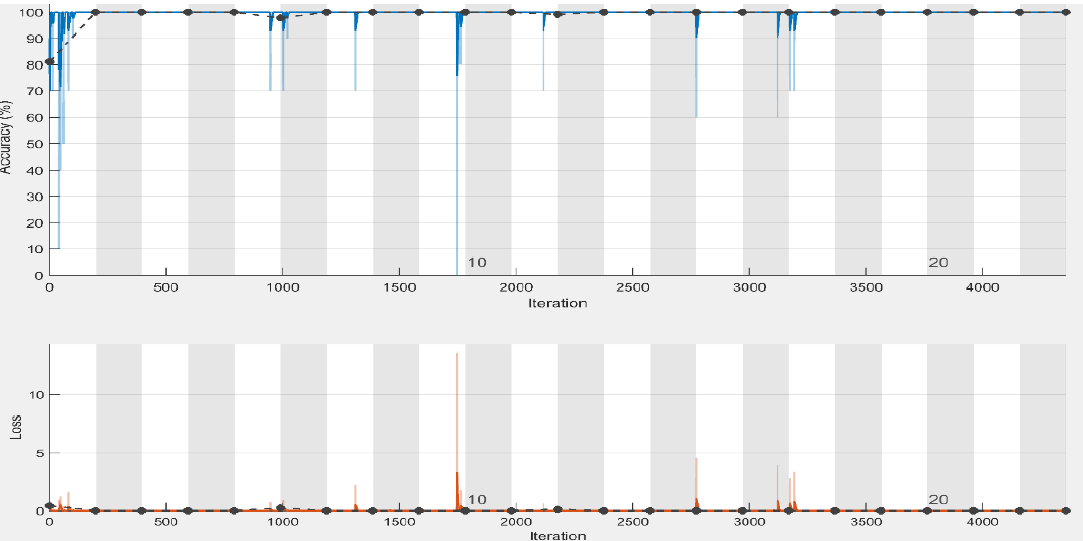
Figure 7. Training and validation accuracy and loss plots of binary classification (black line shows the validation accuracy and loss) using CT scan images.